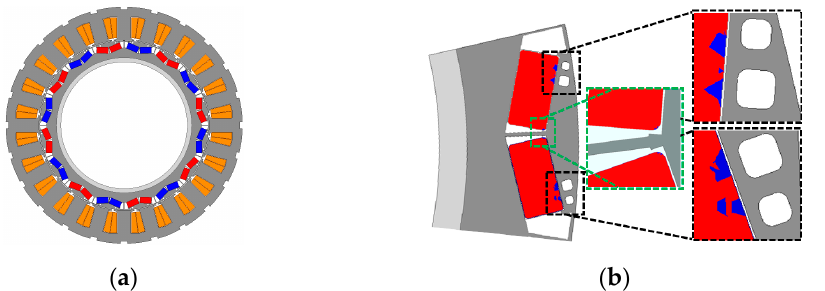
Figure 17. Irreversible demagnetization region by the second air hole position: ( a ) 0 mm, ( b ) 0.6 mm, ( c ) 1.2 mm.